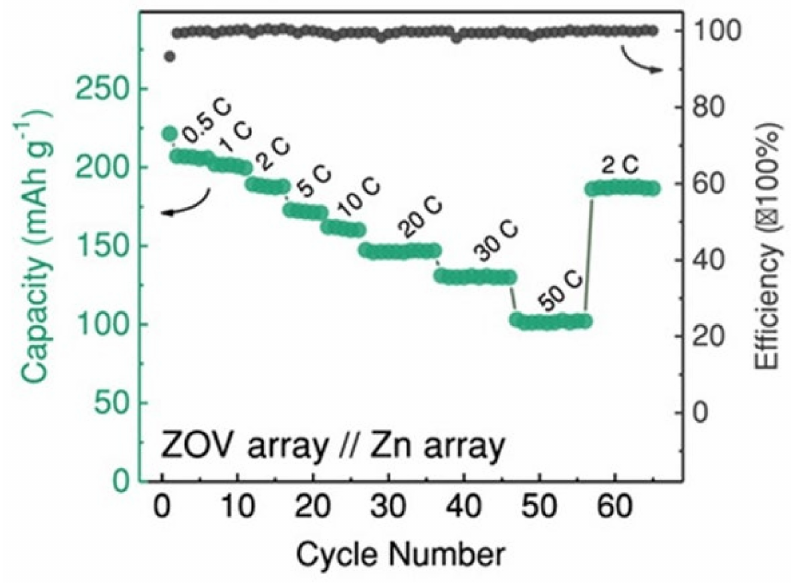
Figure 18. Quasi-solid-state ZIB performance with ZOV array as a cathode and Zn array as an anode. The rate capability of the cell at varied current densities, from 0.5 to 50 C. Reprinted with permission from Ref. [82]. Copyright 2018